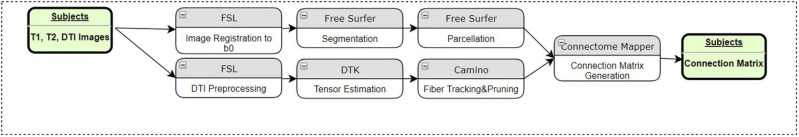
Components of the pre-processing pipeline before TPDS is performed.